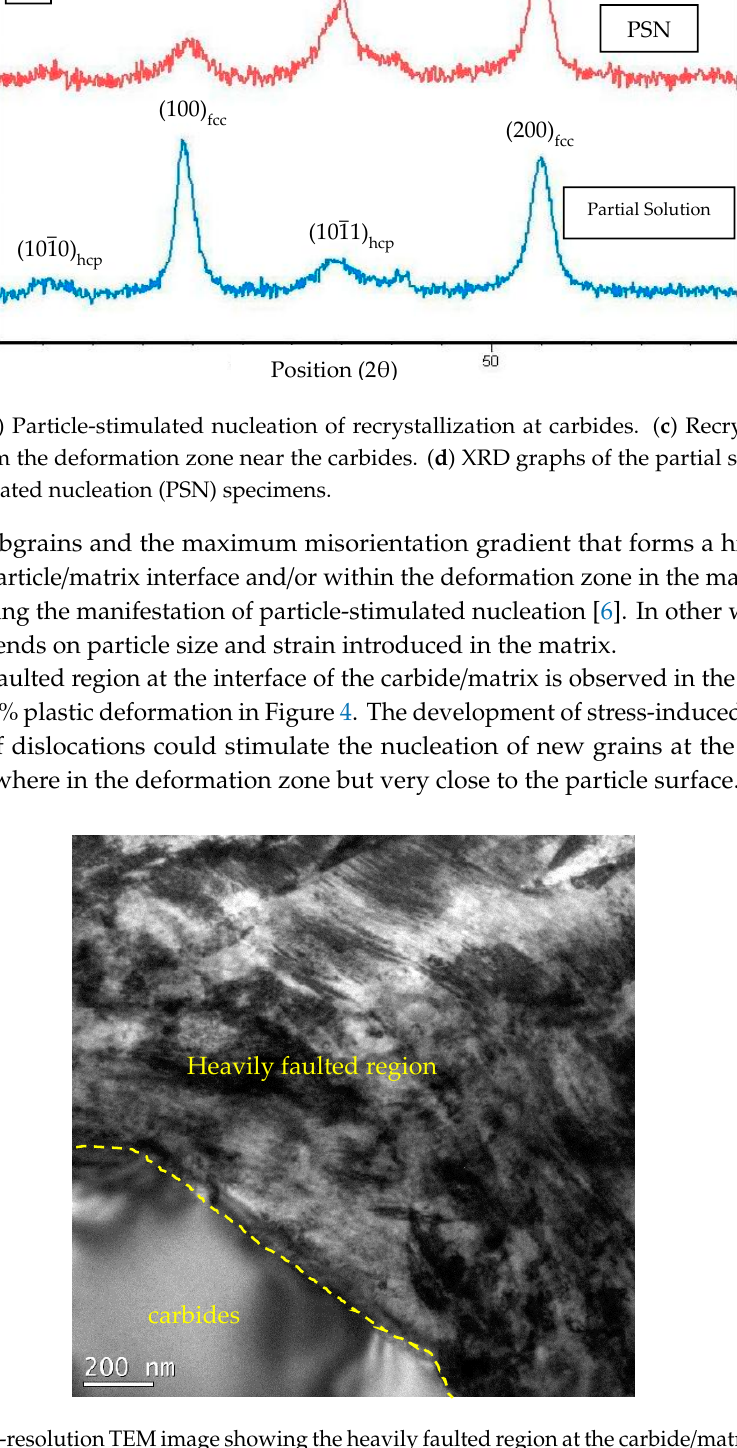
Figure 4. High-resolution TEM image showing the heavily faulted region at the carbide / matrix interface.